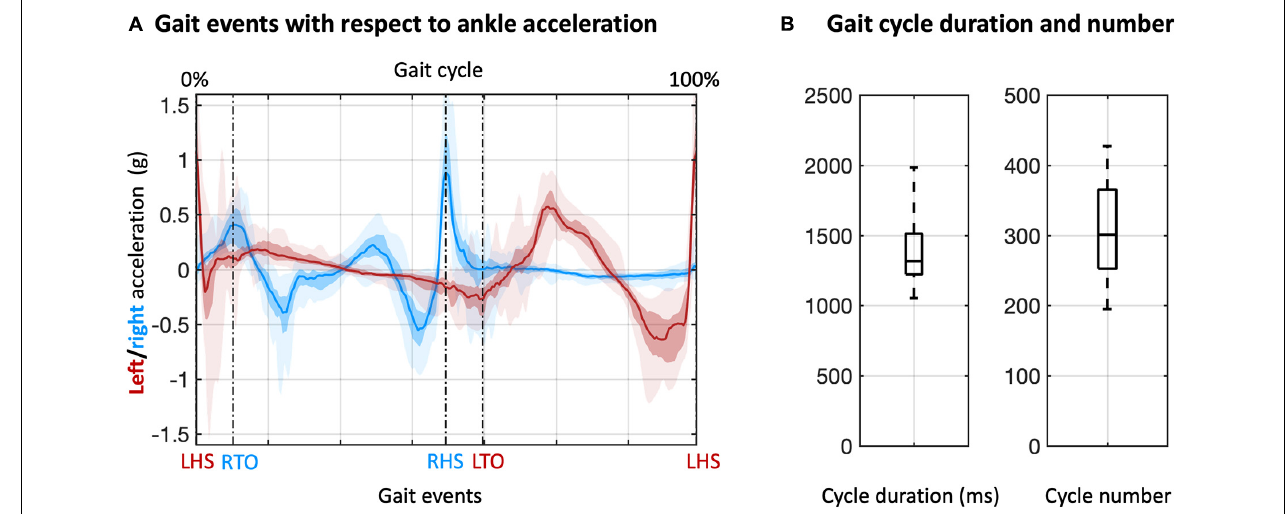
FIGURE 2 | Detection and analysis of gait cycles. (A) Gait cycles were defined based on two adjacent left heel strike (LHS) events, detected from the acceleration of the left and right ankles. The acceleration data were also used to define right toe off (RTO), right heel strike (RHS), and left toe off (LTO) events. The lines denote the median across participants; the colored areas denote the intra-quartile range; the areas with semi-transparent color denote the full-range (from minimum to maximum) across participants. (B) Duration and number of gait cycles across participants.